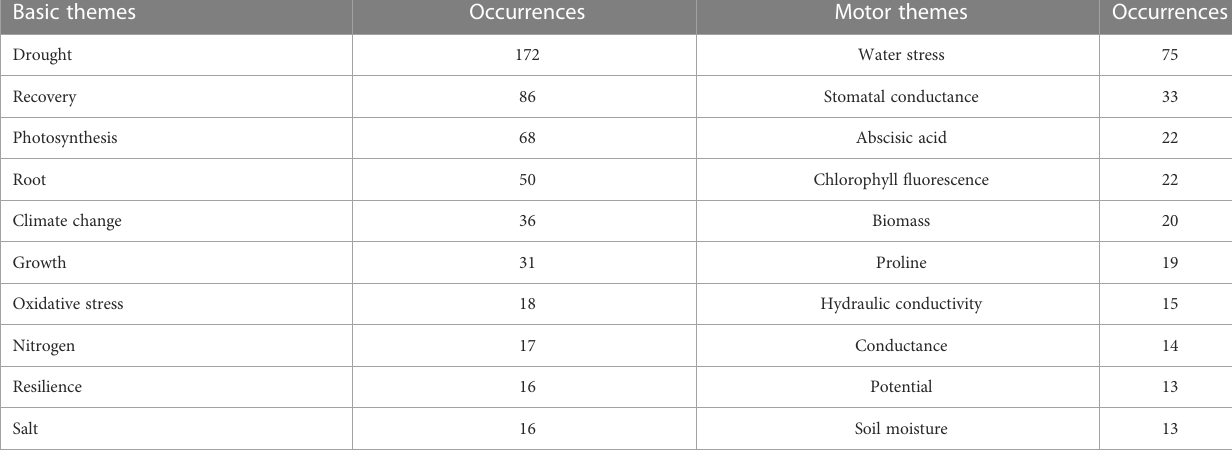
TABLE 2 Top 10 high-frequency keywords in basic and motor themes of thematic analysis on root plasticity during drought and recovery